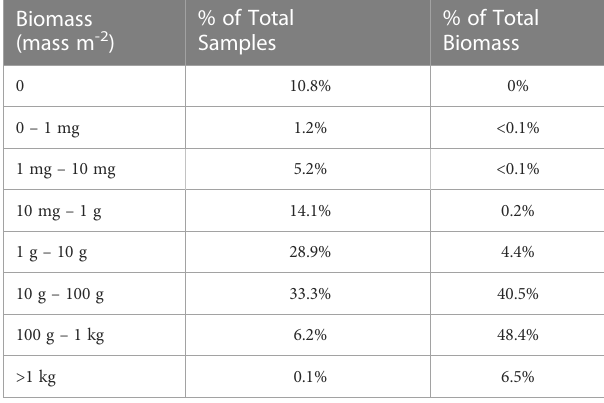
TABLE 7 Breakdown of acoustic samples (n = 83,478) by order of magnitude biomass bins and their contribution to the total biomass